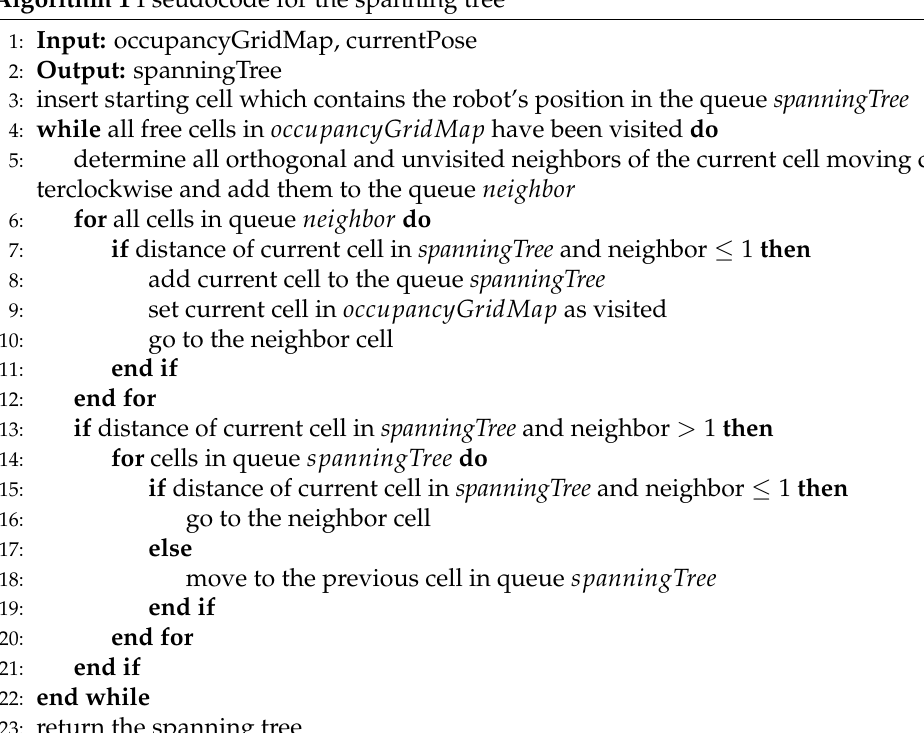
Algorithm 1 Pseudocode for the spanning tree